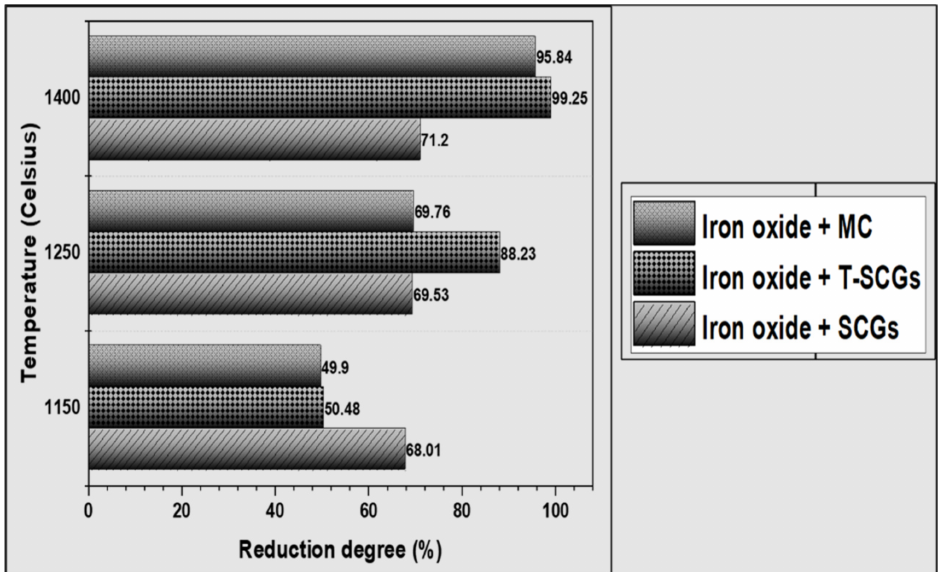
Figure 14. Degree of reduction of hematite-based pellets heat-treated at different temperatures (Adapted from Biswal, et al. [58]. Reproduced with permission from